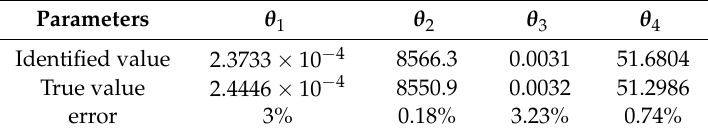
Table 2. The results of parameter identification and true